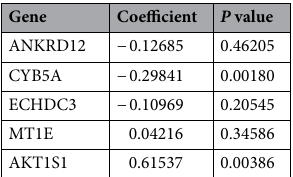
Table 1. Genes included in prognostic gene